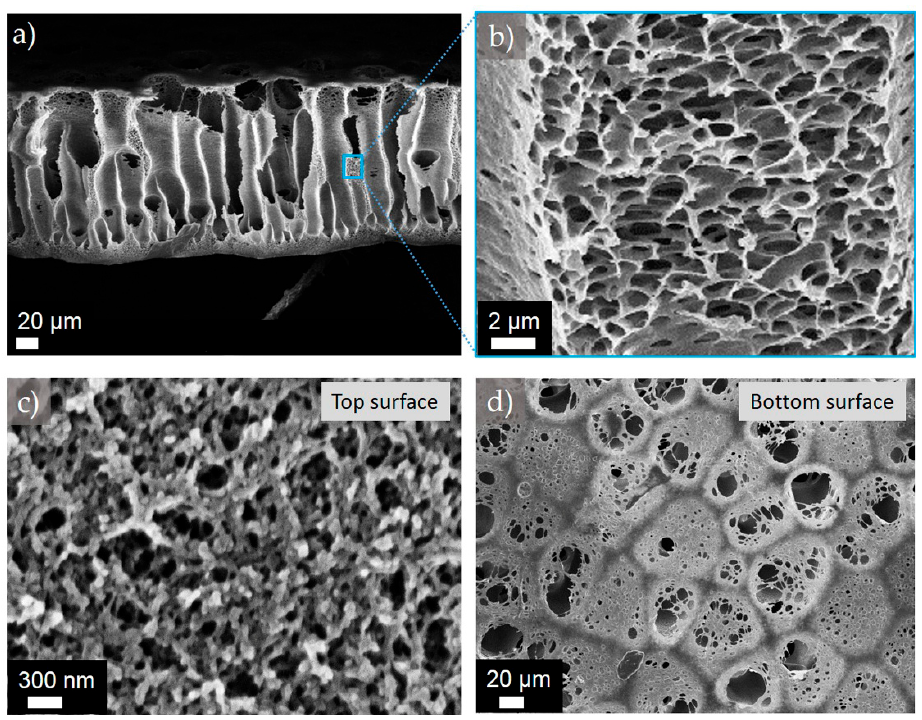
Figure 5. Representative SEM images obtained for the membrane M2-6: ( a ) and ( b ) cross-section at two different magnifications; ( c ) top and ( d ) bottom surface structures.